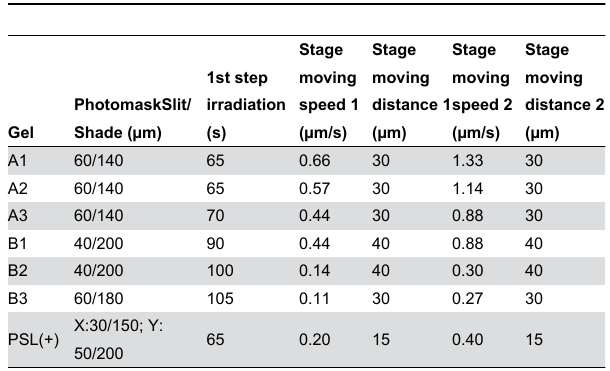
Table 1. Operation parameters for photolithographic micro- elasticity pattering.